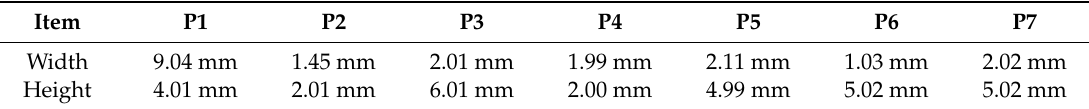
Figure 15. Wear measurement results for the contact strip using the ( a ) first top fitted line, ( b ) second top fitted line, and ( c ) bottom fitted line . Table 3. Error result of the physical value and the detection value of the simulation contact strip.